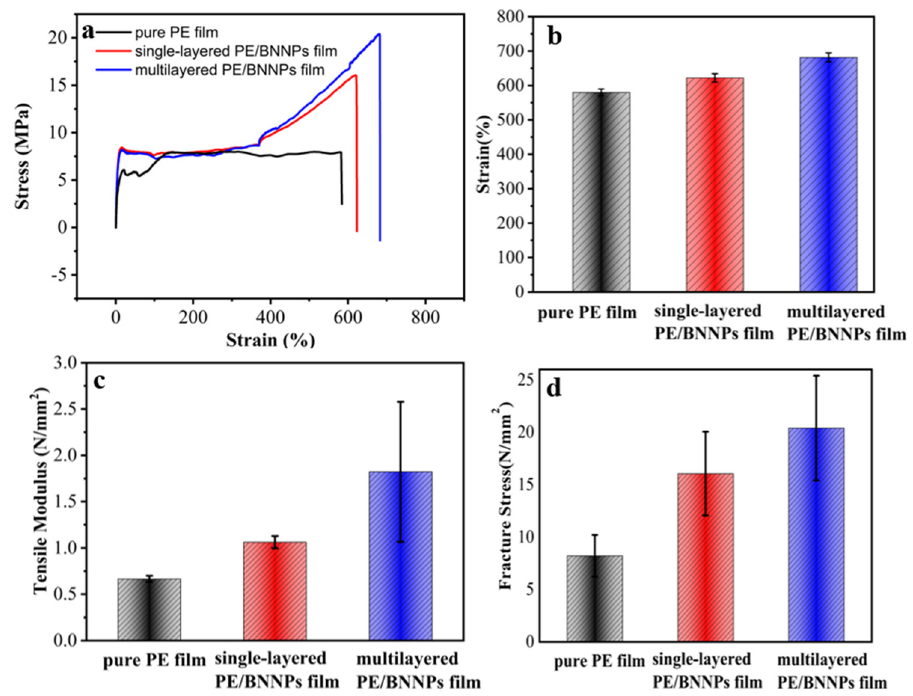
Figure 5. The mechanical property of pure PE film, single-layered PE/BNNPs film, and multilayered PE/BNNPs film. ( a ) The stress–strain curve of different films. ( b ) The maximum strain comparison of different films. ( c ) The tensile modulus comparison of different films. ( d ) The comparison of different films in fracture stress.